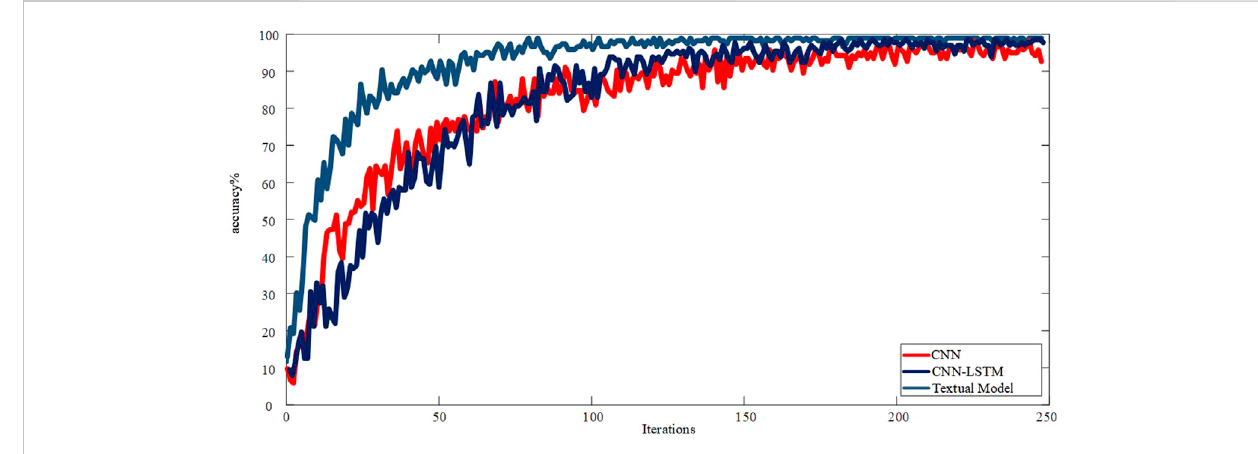
FIGURE 16 Comparison of accuracy results of different model training